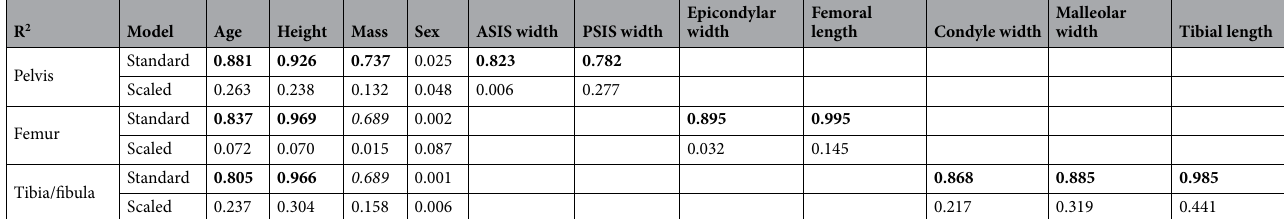
Table 2. Multiple comparison analysis results for the standard and scaled shape models showing the R 2 scores for each predictive factor for the pelvis, femur, and tibia/fibula. Bold shows high percentage variation explained by that factor, and italics shows moderate percentage variation explained.